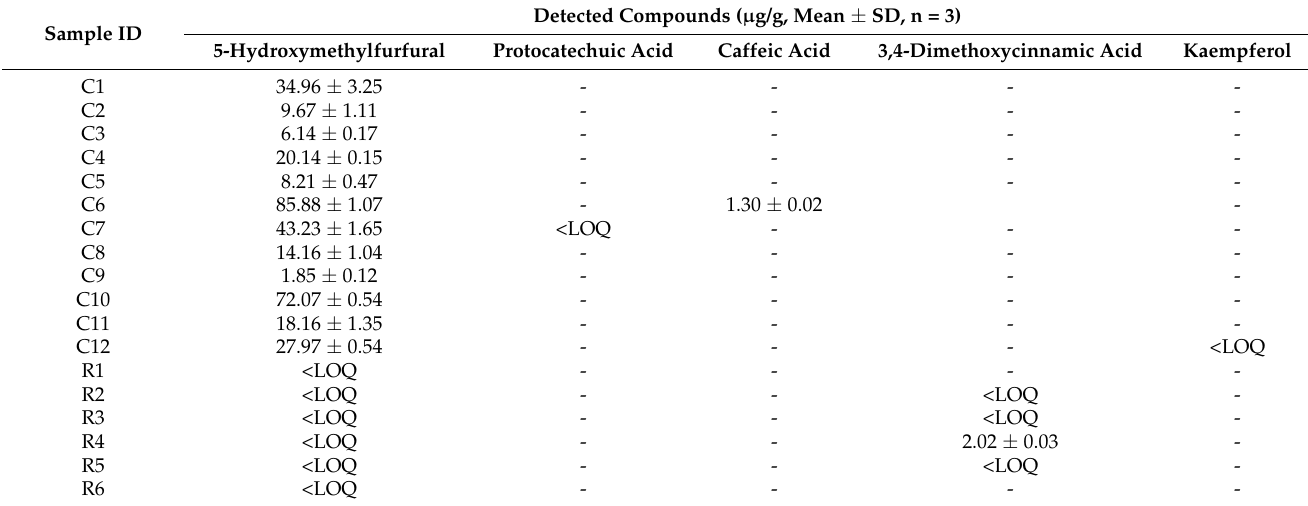
Table 3. Results of detected compounds in the real honey